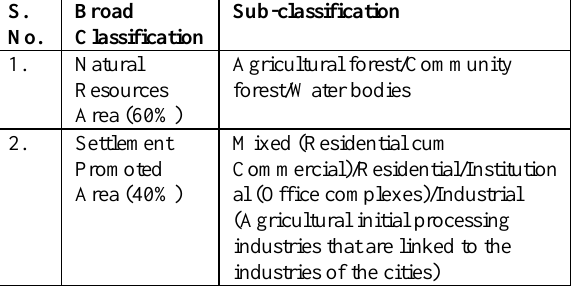
Table 1. Types of land use for Market Center.